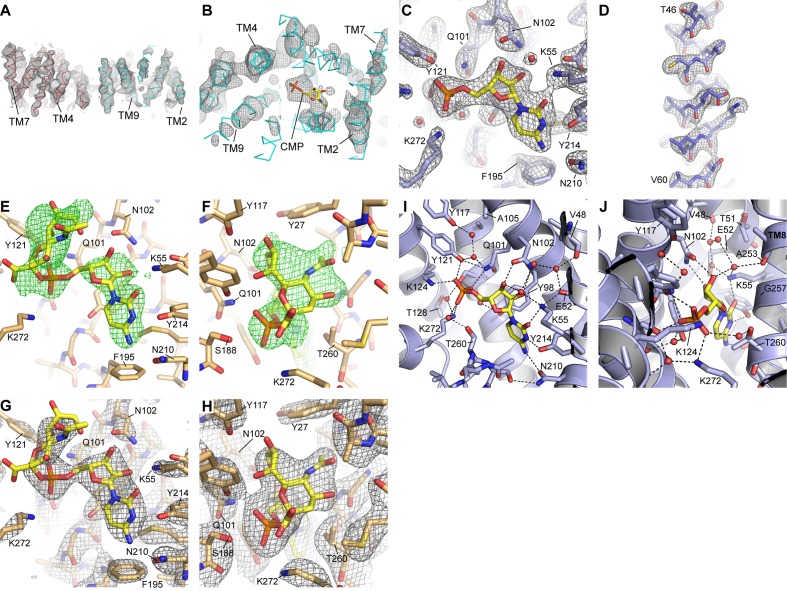
Electron density maps.(A) A density-modified experimental map for the two mCST molecules in the asymmetric unit of the HDVD crystal is shown at 1.8σ. (B) A top-down view of one of the mCST molecules with the same map as in (A) but at 3σ to show the presence of density for CMP. (C and D) 2Fo-Fc maps of the mCST-CMP LCP crystal showing the CMP binding site (C, 1.9σ) and TM2 (D, 1.8σ). Density is seen for all 11 waters in this structure at at least 1.2σ, but only the three waters (red spheres) with density at 1.9σ are shown in (C). (E and F) Positive Fo-Fc density maps (2σ) are shown for two views of the CMP-Sia site of the mCST-CMP-Sia LCP crystal immediately after molecular replacement where the mCST-CMP structure without any ligand present was used as a search model. (G and H) 2Fo-Fc maps of the mCST-CMP-Sia LCP crystal showing the CMP-Sia binding site with a focus on the CMP moiety (G, 1.8σ) and the Sia moiety (H, 1.0σ). The density for the two waters in the CMP-Sia binding site are visible at just under 1σ, so they are not shown in these panels. The views shown in (C) and (E–H) are similar to those in Figure 3. (I and J) Two views of the CMP site of the mCST-CMP structure are shown with waters depicted as red spheres. Black lines indicate polar interaction distances within 3.2 Å.